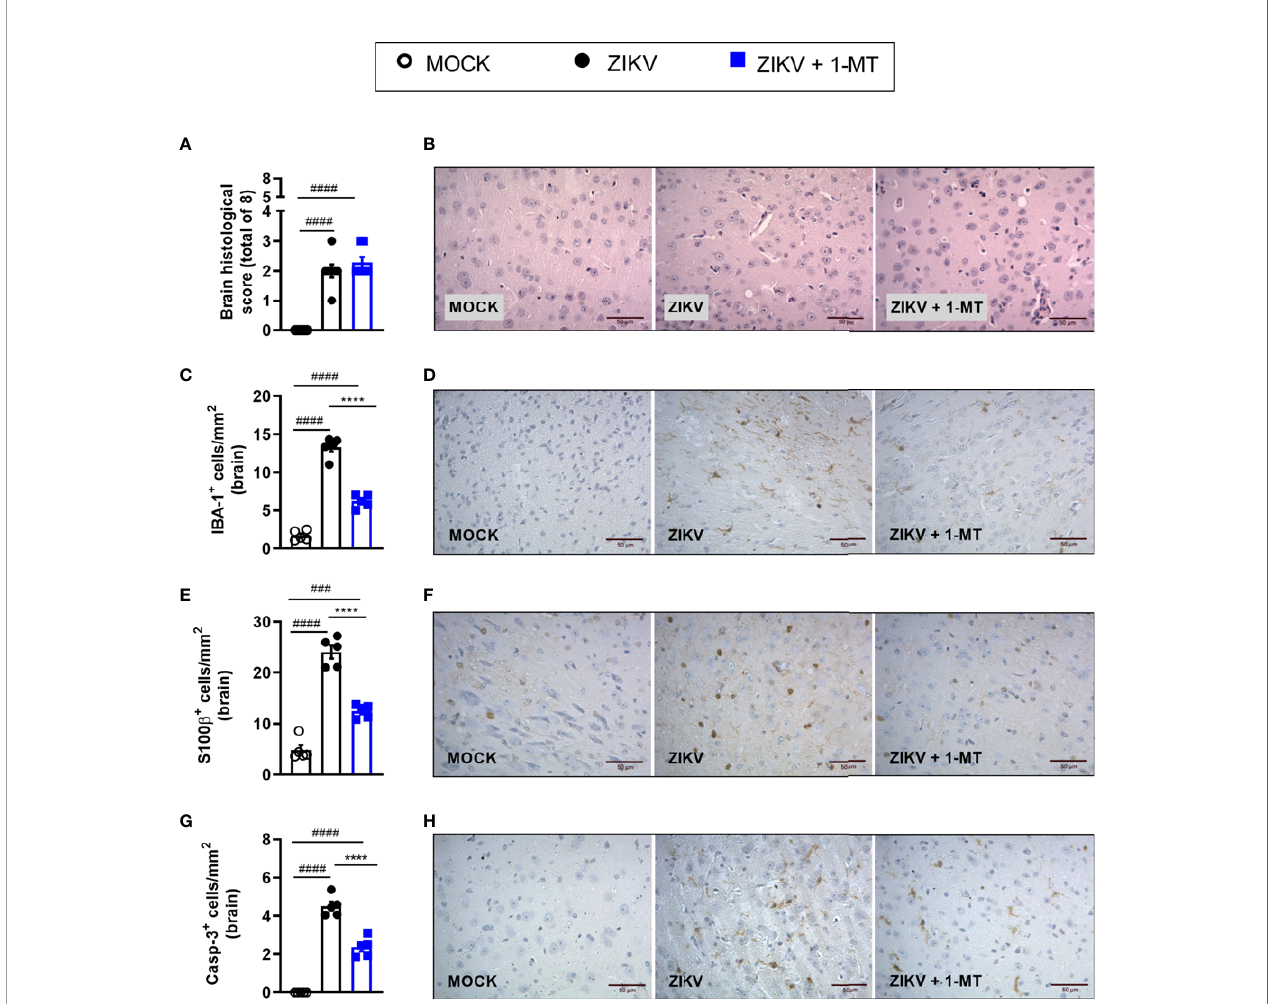
FIGURE 4 | Morphometric analysis of the brain of A129 mice infected by ZIKV, treated or not with 1-MT inhibitor. A129 were inoculated (i.v) with 4x10 3 PFU/200 m L of ZIKV and treated daily with 1-MT. (A) Semiquantitative analysis (histopathological score) after H&E staining of brain sections of ZIKV-infected mice 5 days after infection. (C, E, G) Immunostaining of (C) IBA-1 + , (E) S100- b + and (G) Caspase-3 was performed in the brains of mice. (B, D, F, H) Representative images from brain sections. All results are expressed as mean and error bar indicate the standard error (SEM) and are representative of at least two independent experiments. Statistically signi fi cant differences were assessed by One-way ANOVA plus Tukey ’ s comparisons test. (###) for P < 0,001 and (####) for P < 0,0001 when compared to the MOCK group. (****) for P < 0,0001 compared to the ZIKV